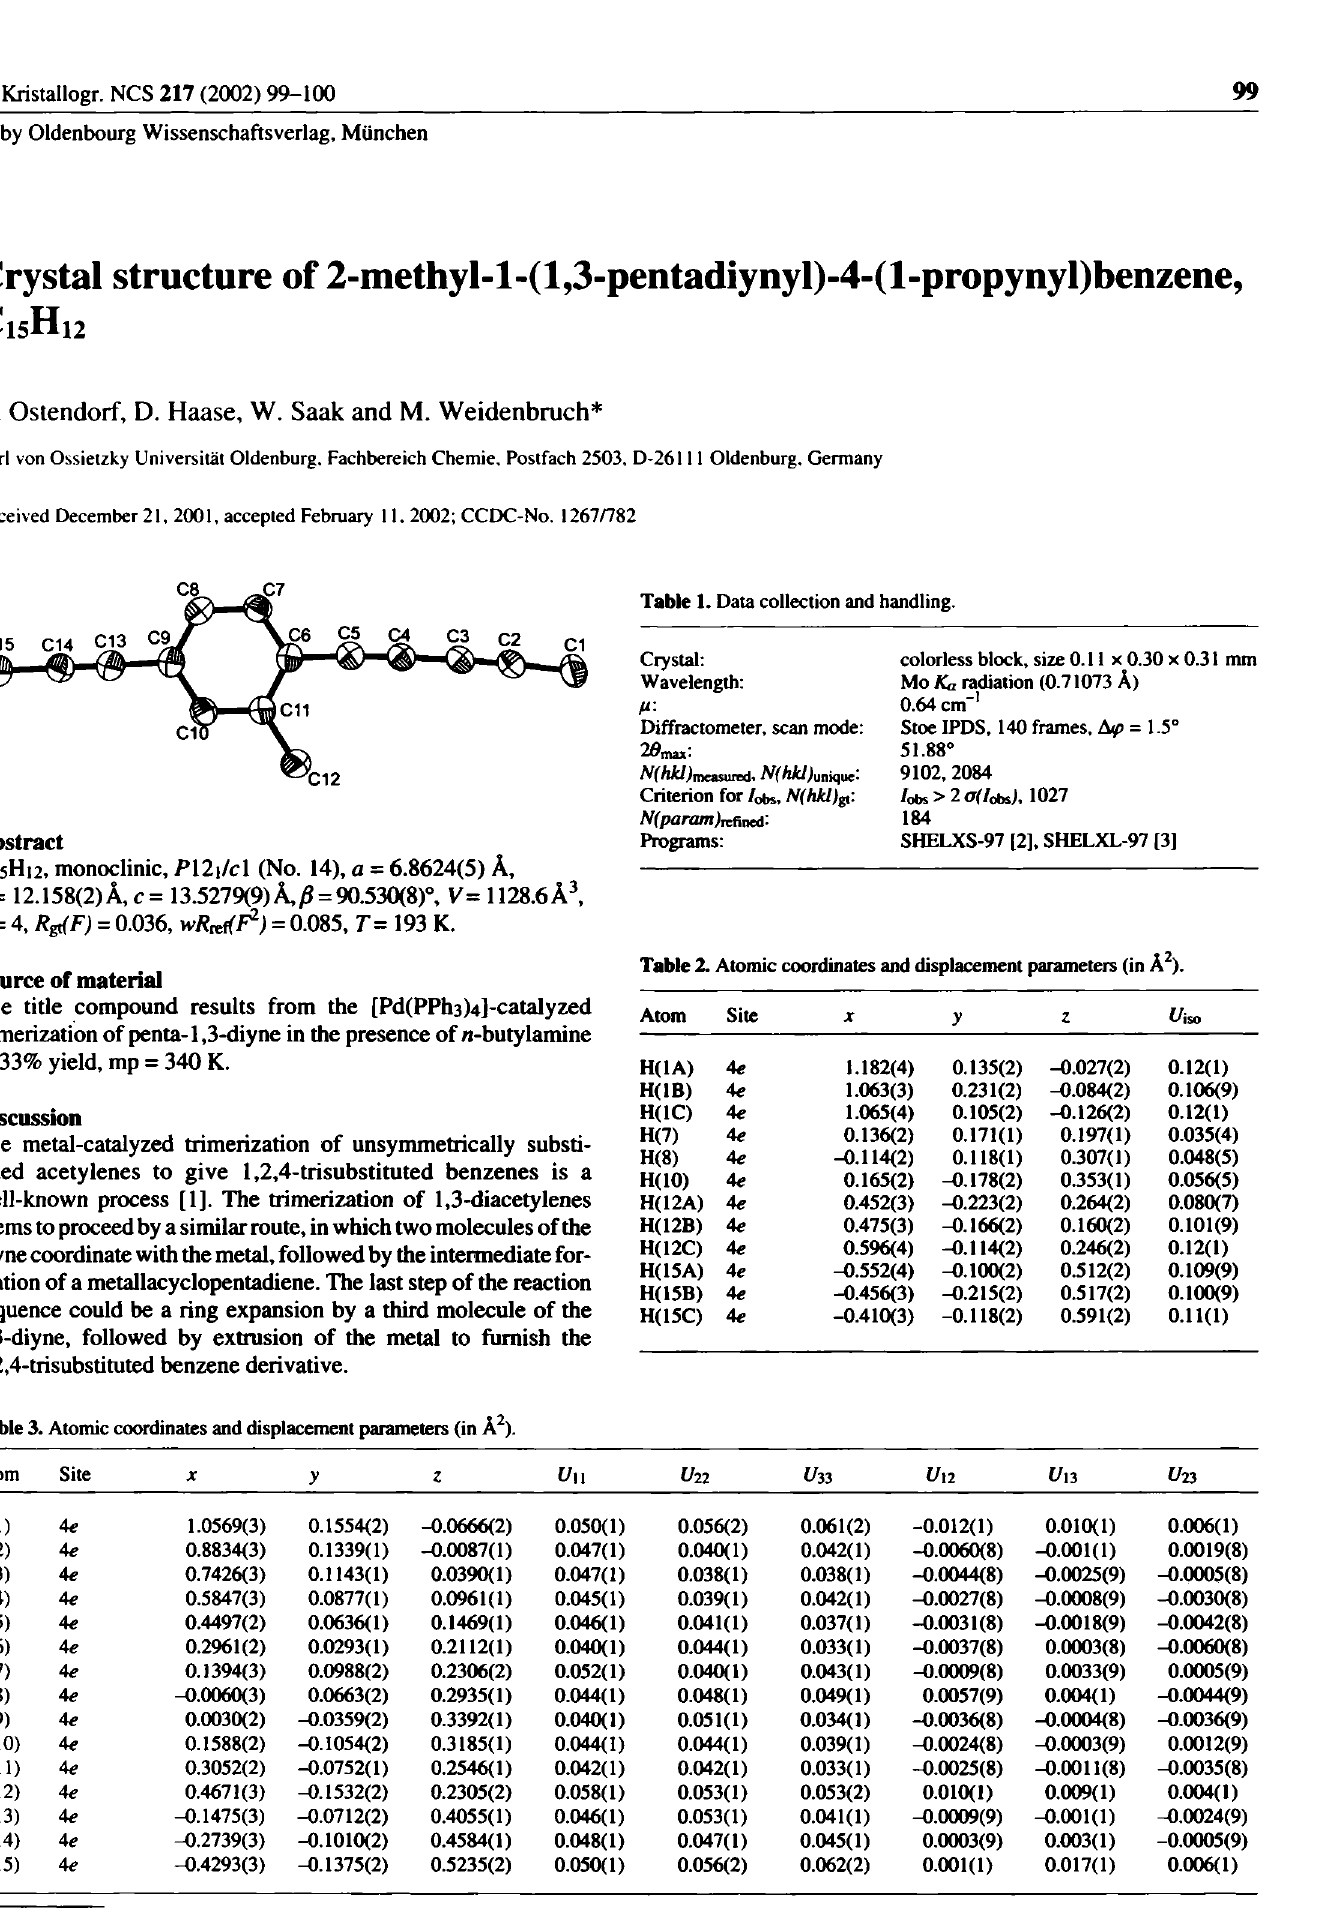
Table 3. Atomic coordinates and displacement parameters (in Â 2